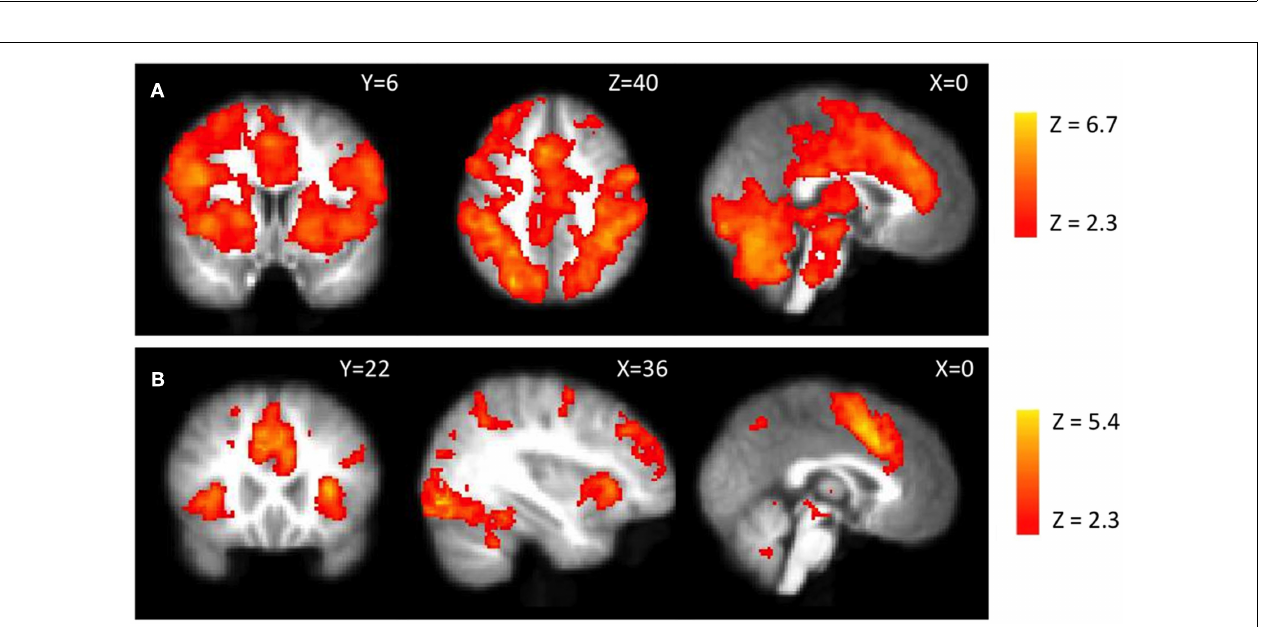
FIGURE 3 | fMRI activations during pumping. (A) Parametric modulation of increasing number of pumps of the rewarded balloons (subtracted by the parametric modulation of the control balloon). Red scale presents Pumps Parametric > Control Parametric and blue scale presents